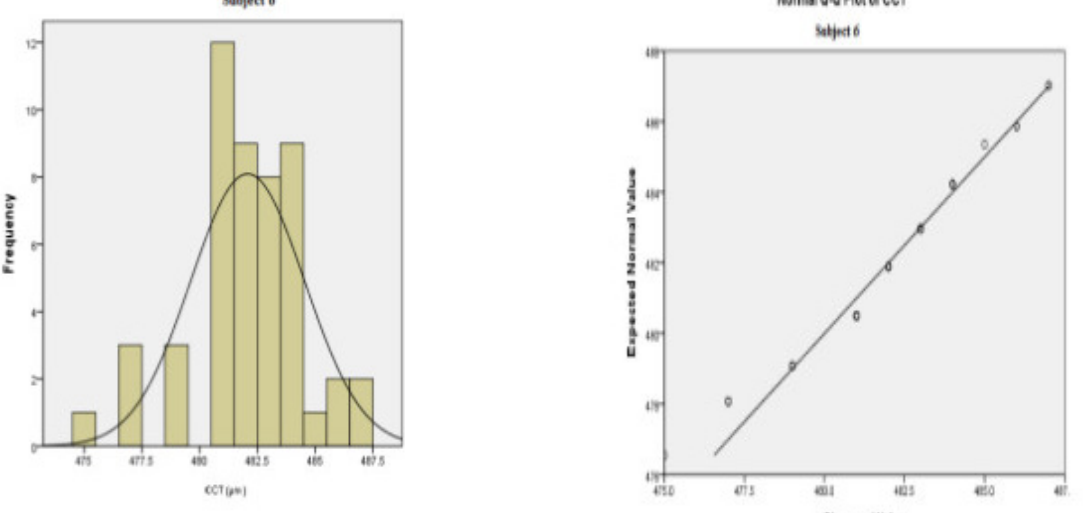
Figure 4: Histograms and normal probability plots for subject 6. The histogram shows the frequency distribution for the CCT measurements.